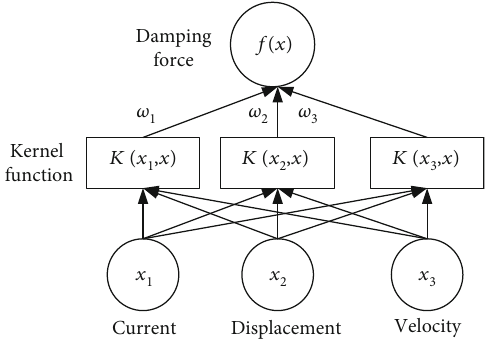
Figure 1: Principle of the SVM